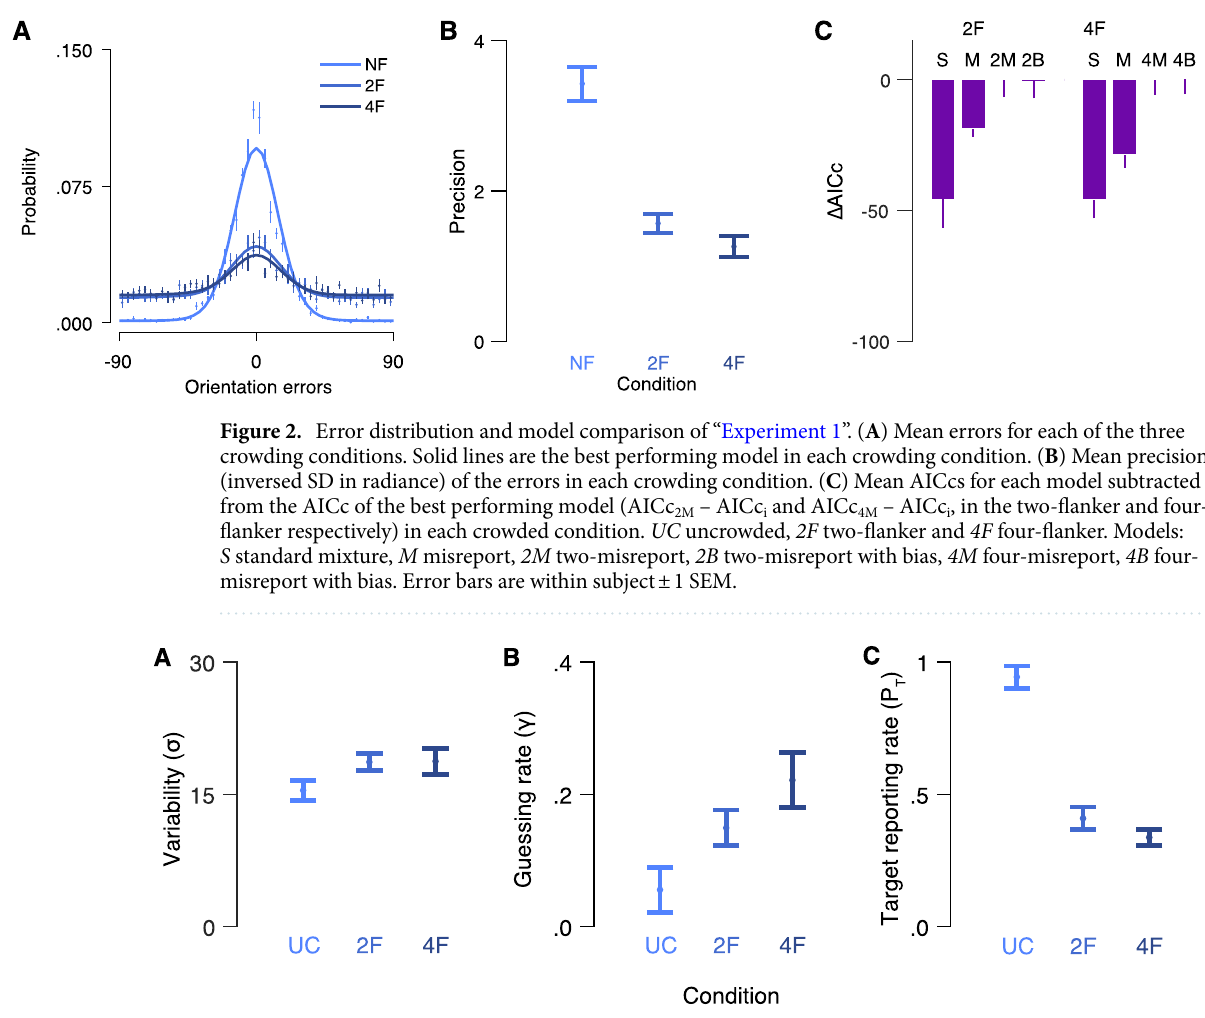
Figure 3. Model parameters in “Experiment 1”. ( A ) Mean variability (σ), ( B ) guessing rate (γ) and ( C ) target reporting rate (P T ) for each crowding condition. UC uncrowded, 2F two-flanker, 4F four-flanker. Error bars are ± 1